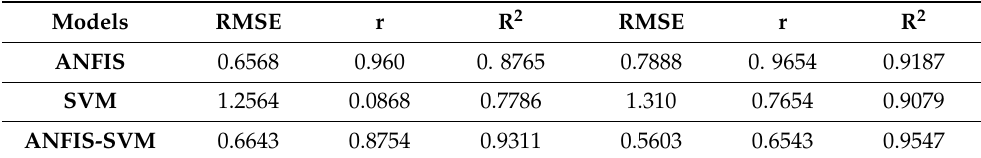
Table 3. The regression output for self-healing soil-cementitious hydrogel materials in mine backfill in both